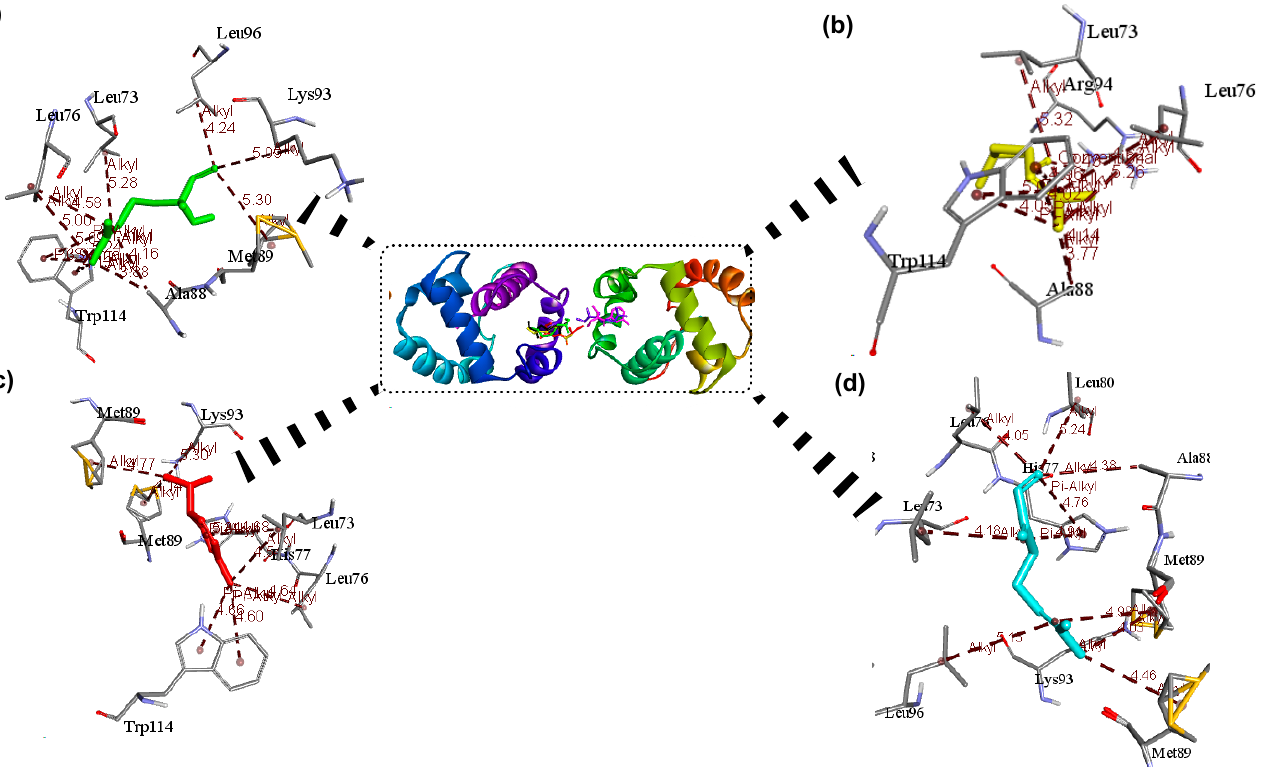
Figure 13. 3D interactions showing the selected ligands: ( a ) linalool, ( b ) citronellal, ( c ) α -phellandrene, and ( d ) myrcene with the most interaction at the active sites of the OBP1.